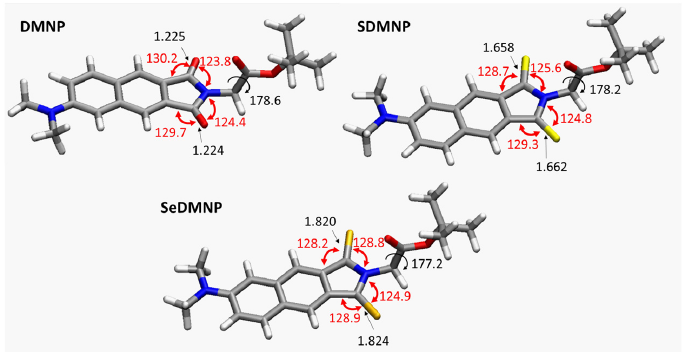
Figure 3. Optimized geometries of DMNP, SDMNP, and SeDMNP in DMSO environment at the B3LYP/6-31+G(d,p) level of theory. The Cartesian coordinates for the optimized structures are reported in Table S1.